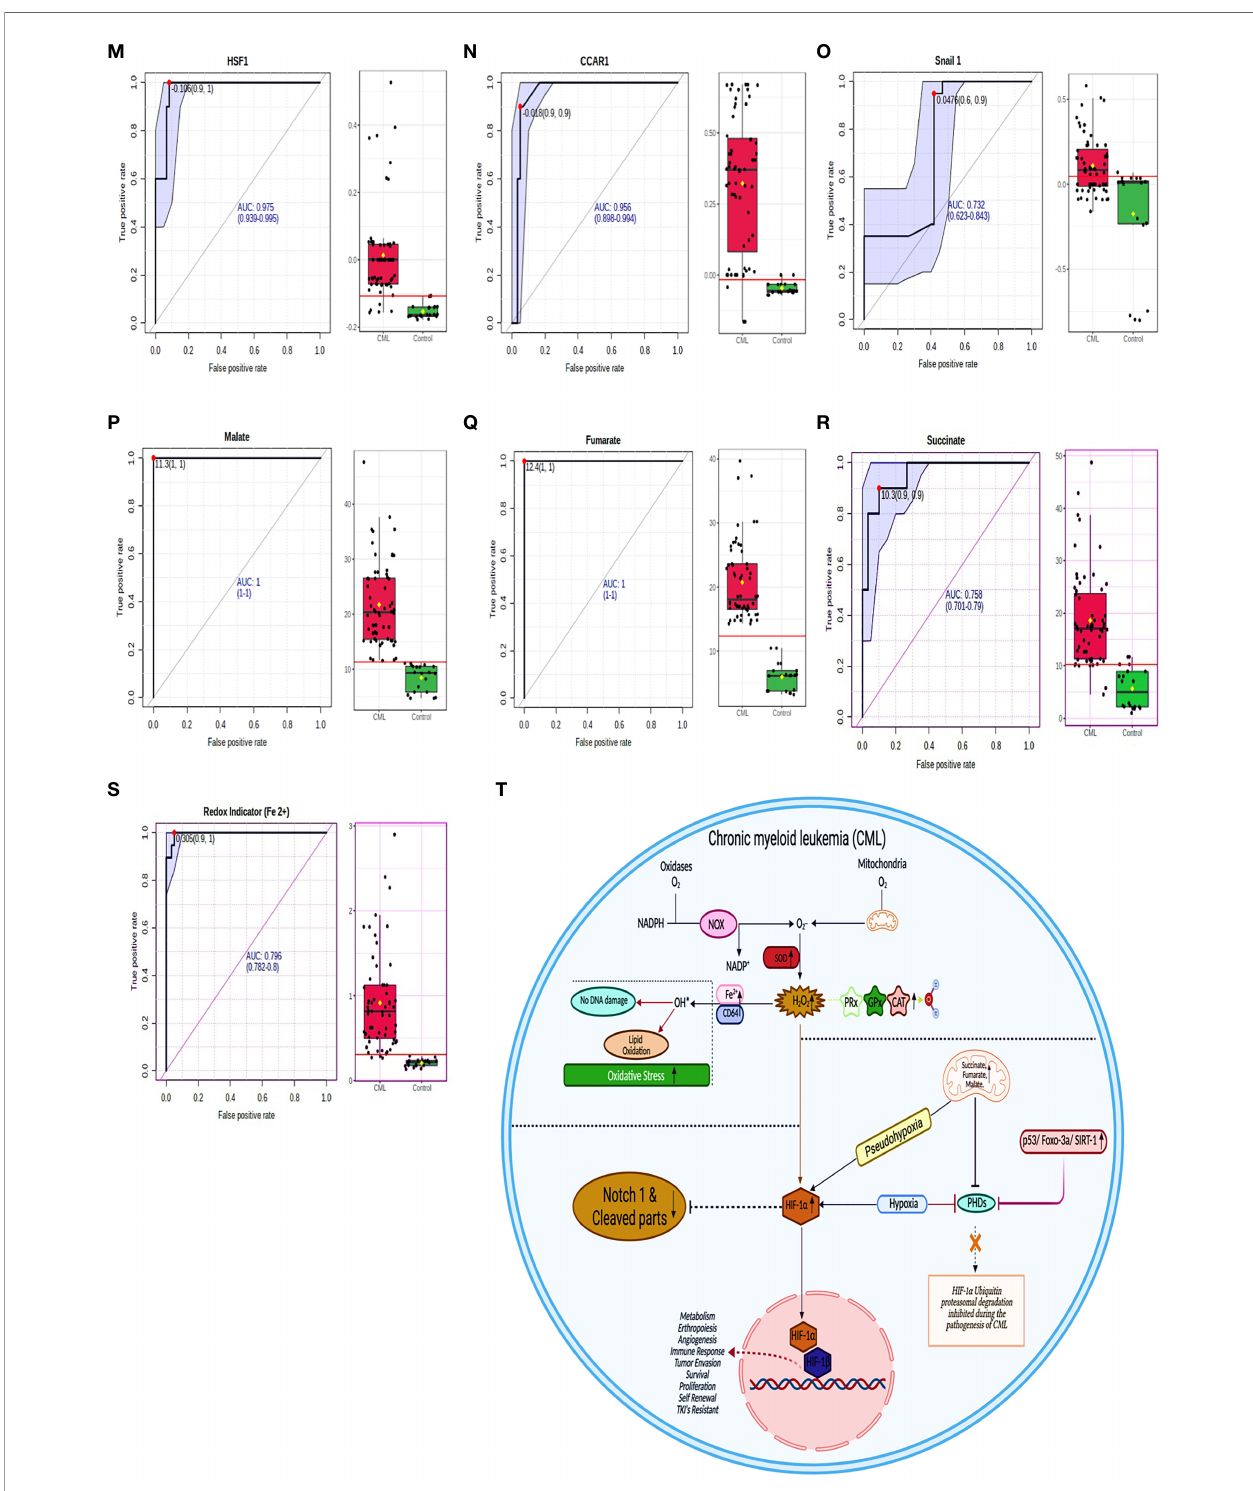
FIGURE 8 | ROC for all the factors in CML samples. (A – S) AUROC shows that HIF1 a , Notch 1, Notch 4, Lgd, Foxo-3a, p53, TNF a , CDH1, CD11d, GAPDH, malate, and fumarate have 100% sensitivity and 100% speci fi city, while Notch 2 (sensitivity- 80%, speci fi city- 90%), Ikaros, (sensitivity- 100%, speci fi city- 90%), HSF1 (sensitivity- 90%, speci fi city- 100%), CCAR1 (sensitivity- 90%, speci fi city- 90%), Snail1 (sensitivity- 60%, speci fi city- 90%), succinate (sensitivity- 90%, speci fi city- 90%), and Redox indicator Fe 2+ (sensitivity- 90%, speci fi city- 100%). See also Figure S2 . (T) Overall mechanism explained in HIF1 a /Notch1